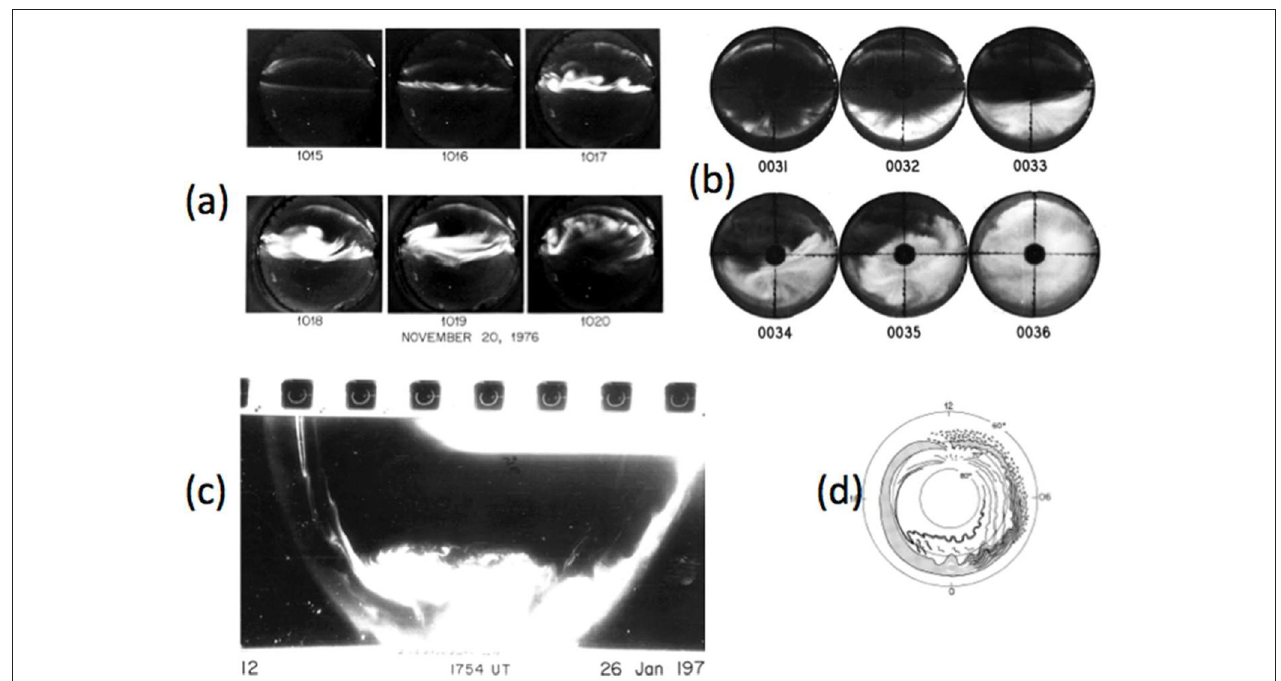
FIGURE 2 | (a) A series of all-sky images, showing the initial brightening of an arc and indicating the onset of an auroral substorm over Fairbanks, Alaska (gm. lat. 65 ◦ N); the circular images cover the whole sky, the top is oriented toward the geomagnetic north. (b) A series of all-sky images, showing the poleward advance of arcs. (c) A satellite (DMSP) image of dark side of the polar region, showing the maximum stage of the expansion phase. (d) A schematic global illustration of auroral activity during a typical substorm; the top of the circle points 12h and the bottom 0h, and the ground-projection of auroral arcs are shown by lines.